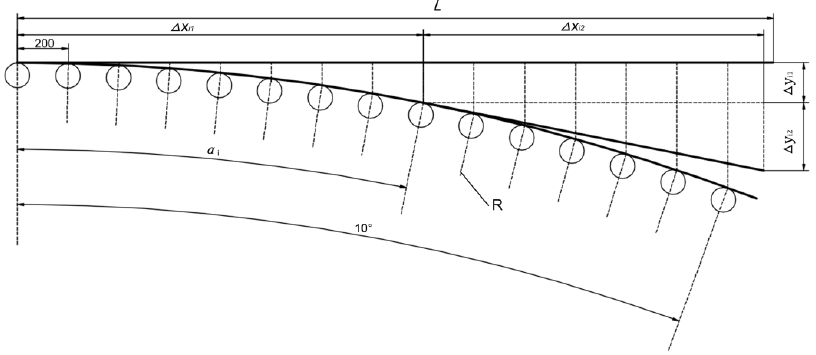
Figure 6. The calculation diagram of special position of clamp track.